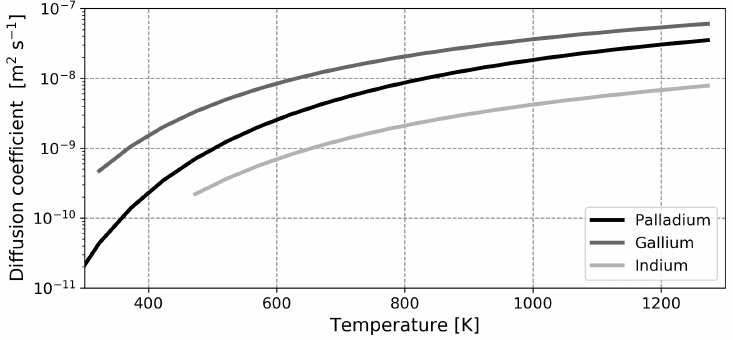
Figure 5. Calculated diffusion coefficients for palladium, gallium and indium.